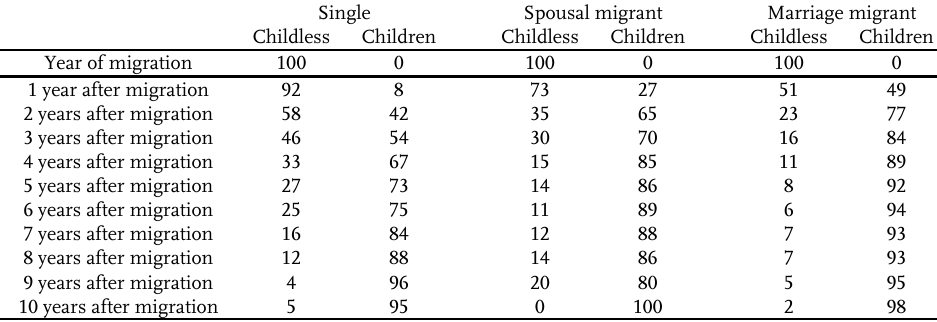
Table 2 : Person-year distribution by migration group and childless/not childless if they have not entered employment, column % Single Spousal migrant Marriage migrant Childless Children Childless Children Childless Children Year of migration 100